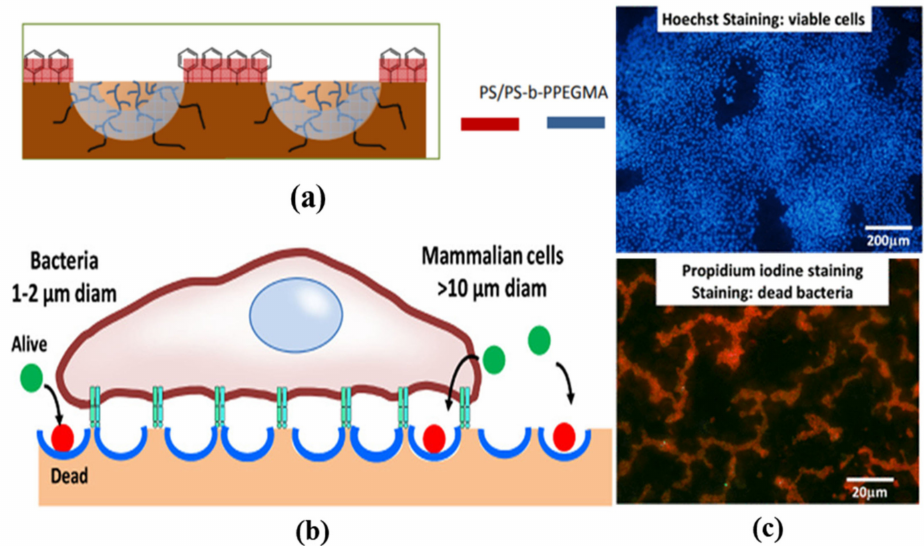
Figure 7. ( a ) Schematic representation of the chemical distribution of the blends of PS and PS-b- PPEGMA (75:25 wt% blend) at the surface. Reprinted with permission from ref. [80]. Copyright 2016 ACS Applied Materials & Interfaces. ( b ) Scheme of the strategy for selective cell culture. Mammalian cells interact only adhere to the top surface, while the bacteria may enter inside the pores due to size differences and get affected by antimicrobial functional groups. ( c ) Cell adhesion tests using (actin staining (red), and Hoechst (blue)) after 96 h of culture on the fabricated film. Reprinted with permission from ref. [5]. Copyright 2017 ACS Applied Materials &